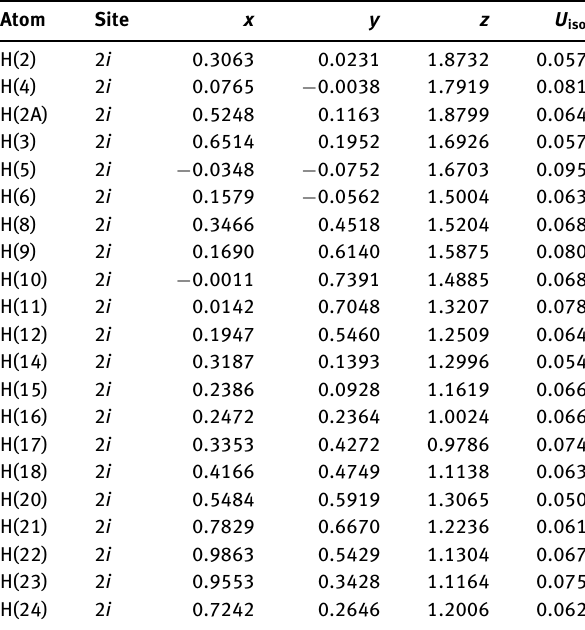
Table 2: Fractional atomic coordinates and isotropic or equivalent isotropic displacement parameters (Å 2